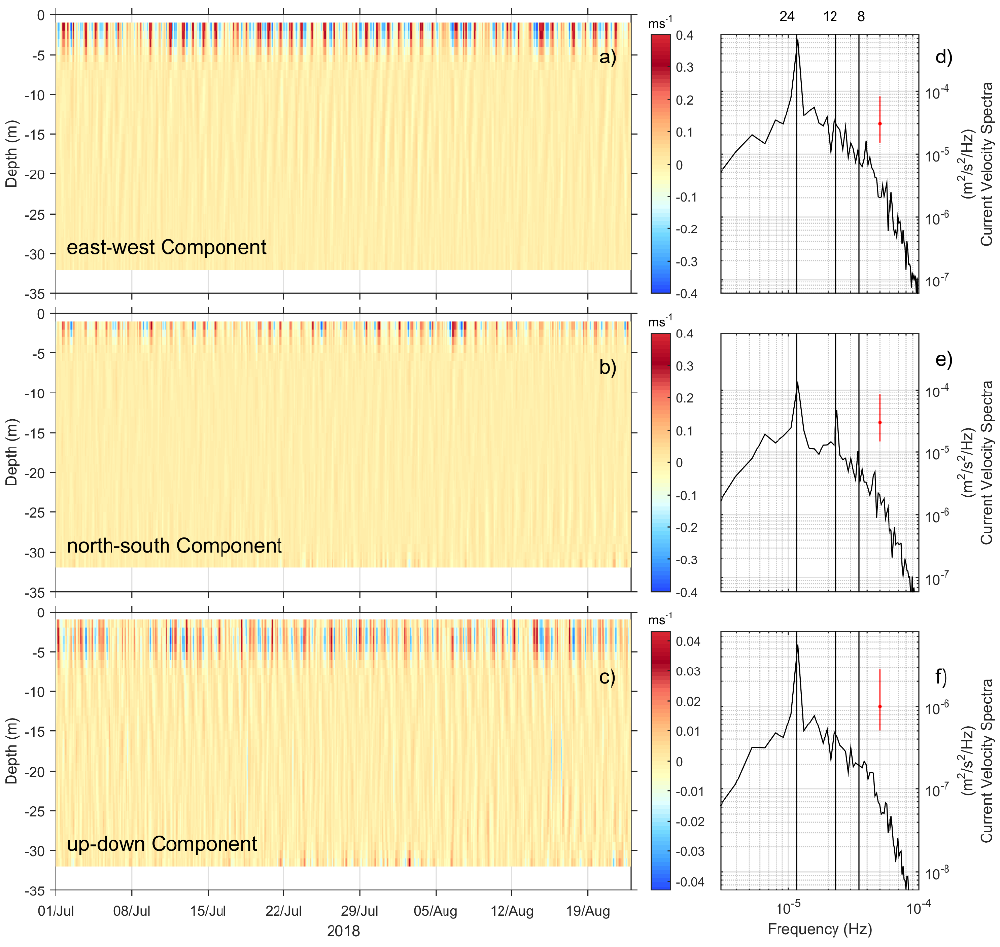
Figure 13. Velocity components obtained during July–August. ( a ) East-west component, ( b ) north-south component, and ( c ) up-down component. Power spectral density for the depth-average time series are shown in ( d – f ). The red bar is the 95% confidence interval.